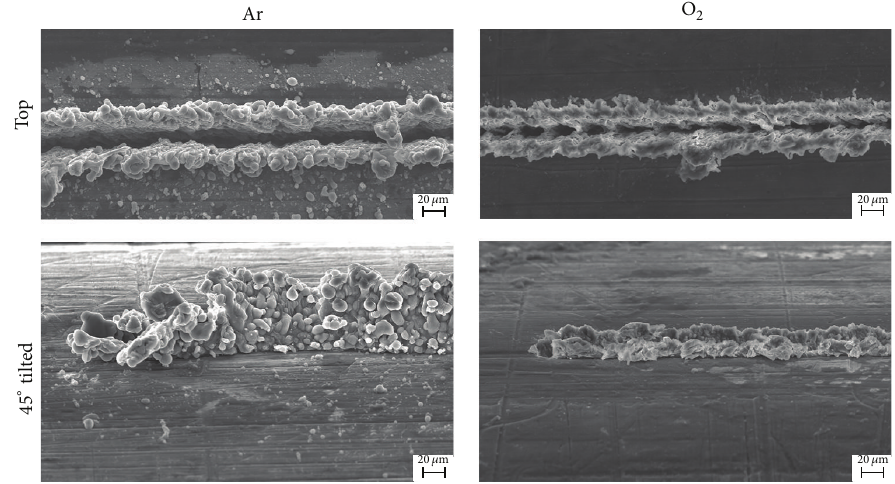
Figure 4: SEM images of the linear incisions on the AZ31 tube obtained with Ar and O 2 process